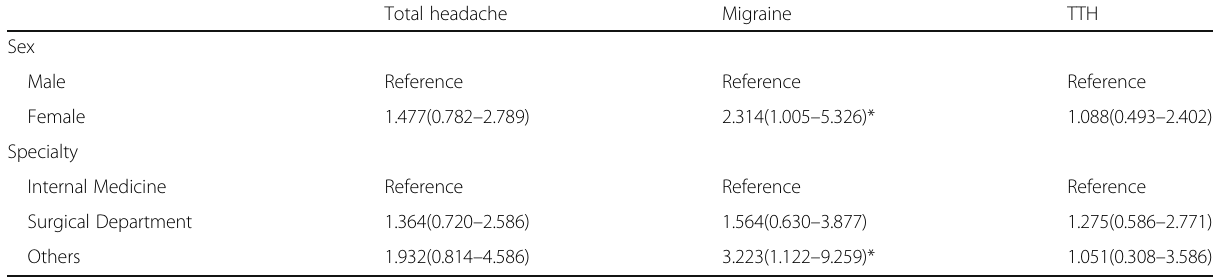
Table 6 Multivariable adjusted odds ratios (95% confidence interval) for total headache, migraine, and tension-type headache (TTH) among doctors Total